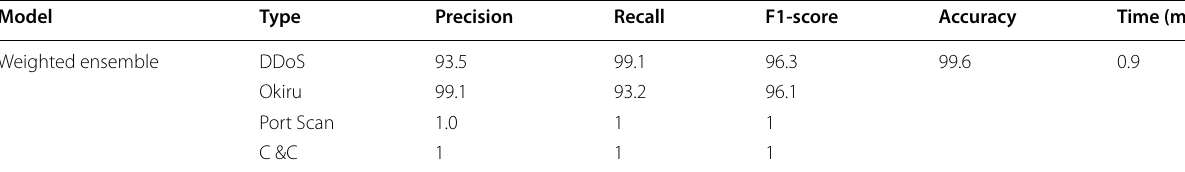
Table 6 Results for attack only data—attack classification in batch mode using ensemble classifiers